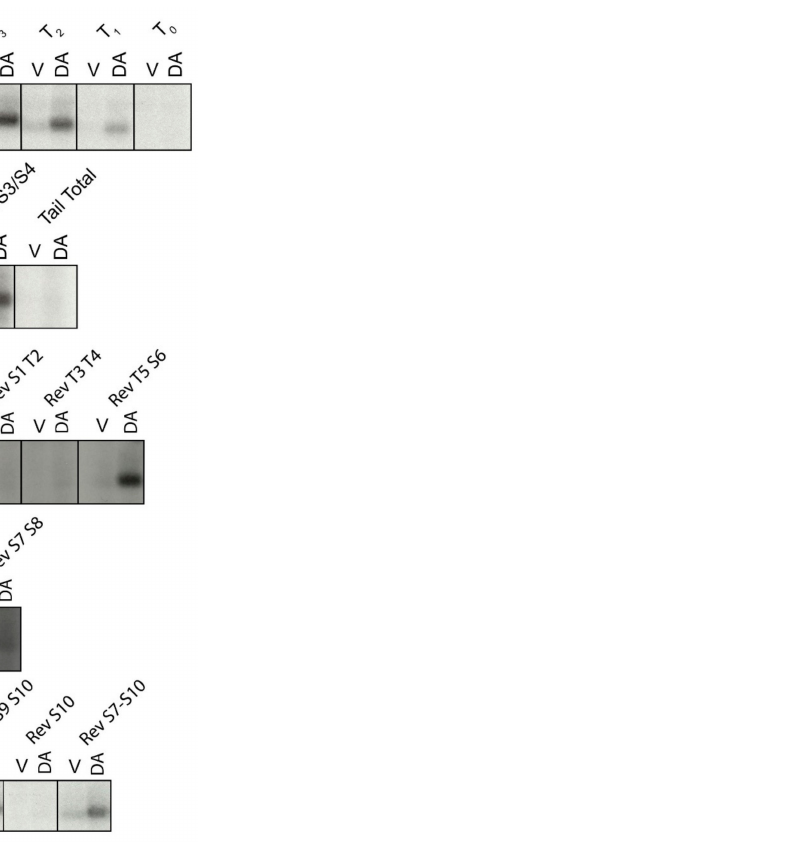
Figure 2. Mutational analyses reveal dopamine-stimulated (GRK-mediated) D1R phosphorylation sites. In situ phosphorylation assays were performed as described in Section 4. Briefly, wild- type (WT), site-specific, reverse (Rev), or C-terminal truncation mutants of the D1R were treated with either vehicle (labeled “V”) or 10 µ M dopamine (labeled “DA”) for 15 min prior to cell lysis, immunoprecipitation, resolution by SDS-PAGE, and autoradiography. Within each panel, equal amounts of D1R protein, as quantified by radioligand binding, were loaded into each lane of the gels. Representative experiments are shown, which were performed at least twice with similar results. Numbering scheme for the site-specific, reverse (Rev), and truncation mutants are shown in the receptor diagram in Figure 1. ( a ) The D1R WT and C-terminal truncation mutants T 0 , T 1 , T 2 and T 3 are shown. ( b ) The D1R WT, triple ICL3 mutant S2/S3/S4, and mutant Tail Total (in which all 20 C-terminal serines and threonines are mutated) are shown. ( c ) The D1R WT and reverse mutants Rev S1T2, Rev T3T4, and Rev T5T6 are shown. ( d ) The D1R WT and reverse mutant Rev S7S8 are shown. ( e ) The D1R WT and reverse mutants Rev S9S10, Rev 10, and Rev S7–S10 are